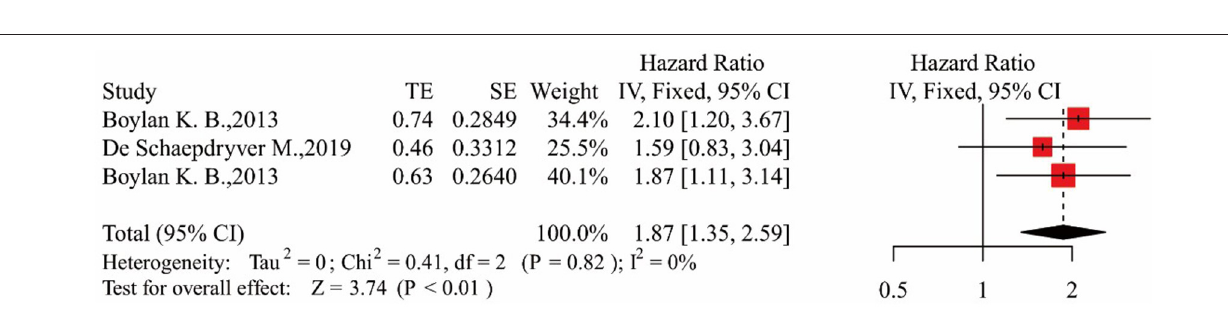
FIGURE 4 | Forest map showing the relationship between NfL levels and survival (high NfL group relative to low NfL group).